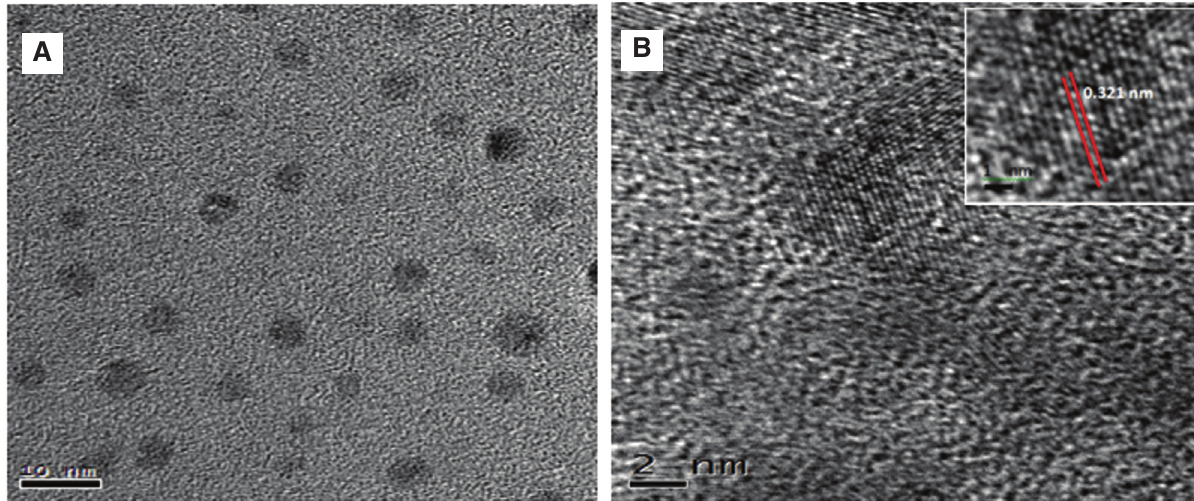
Figure 2: (A) and (B) transmission electron microscopy (TEM) images of received carbon quantum dots (CQDs). The inset in (B) is the high- resolution TEM (HRTEM) image of CQDs.